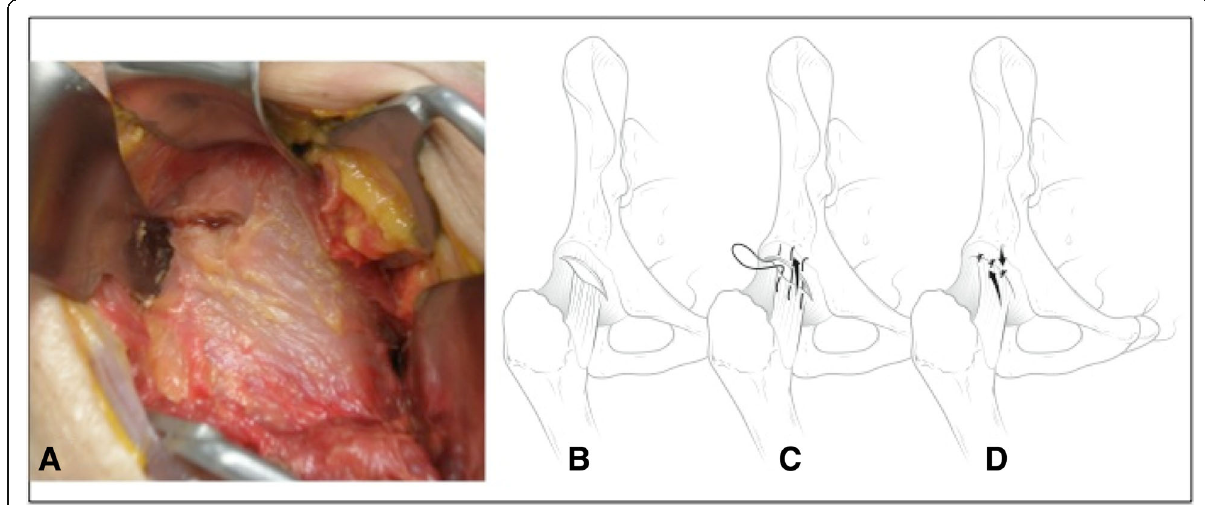
Fig. 2 a and b shows the extent of the interportal capsulotomy performed initially. c demonstrates the primary plication technique with a slight shift of the distal limb from medial to lateral. d represents the end product of capsular closure which was completed with 3 sutures